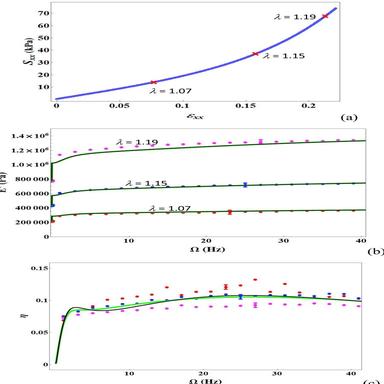
Storage modulus E and loss tangent η at three different initial stretches λ for the axial media from donor VII versus loading frequency Ω (Hz). The error bar quantifies the estimated measurement error. , experimental data for λ = 1.07; , experimental data for λ = 1.15; , experimental data for λ = 1.19; —, generalized Maxwell material model with NS=3 and R2 = 0.767 for λ = 1.15; , generalized Maxwell material model with NS=4 and R2 = 0.795 for λ = 1.15. (a) Stress-strain law with indication of the three init